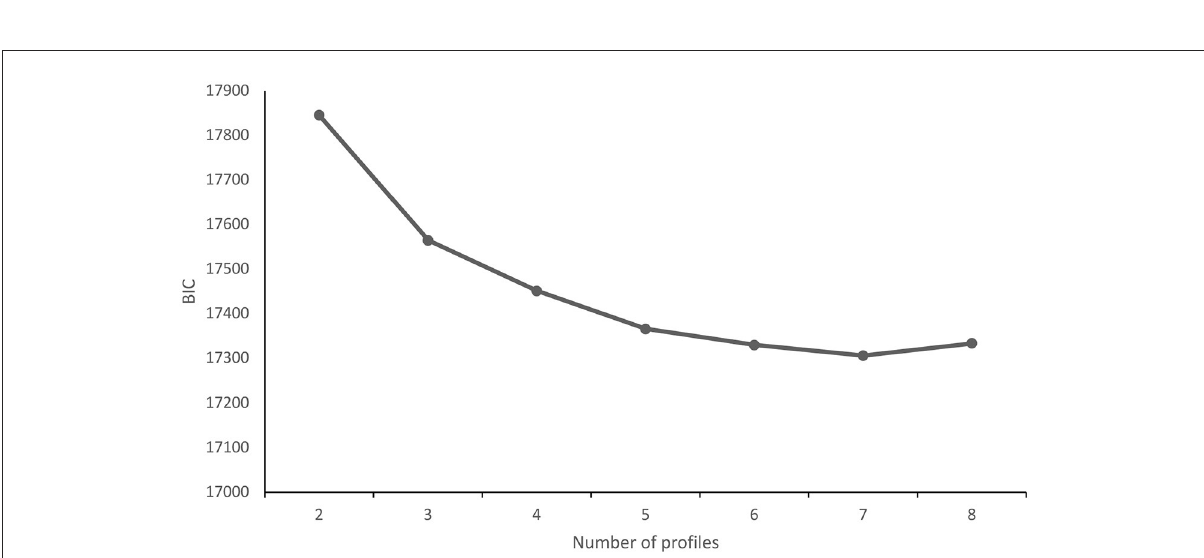
FIGURE3 Goodness of fit of the BIC. The y-axis represents BIC (Bayesian information criterion); the x-axis represents the number of profiles (starting from